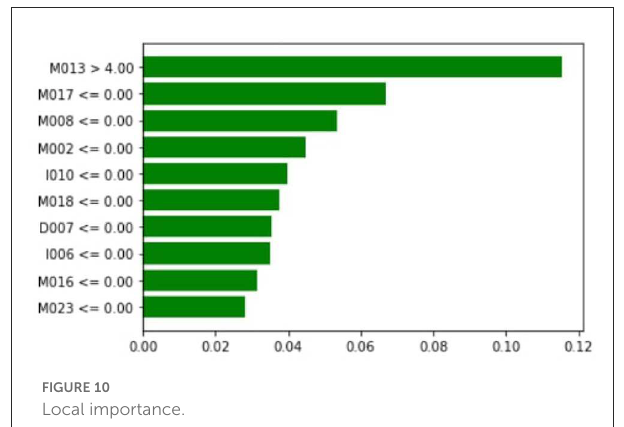
FIGURE10 Local importance.